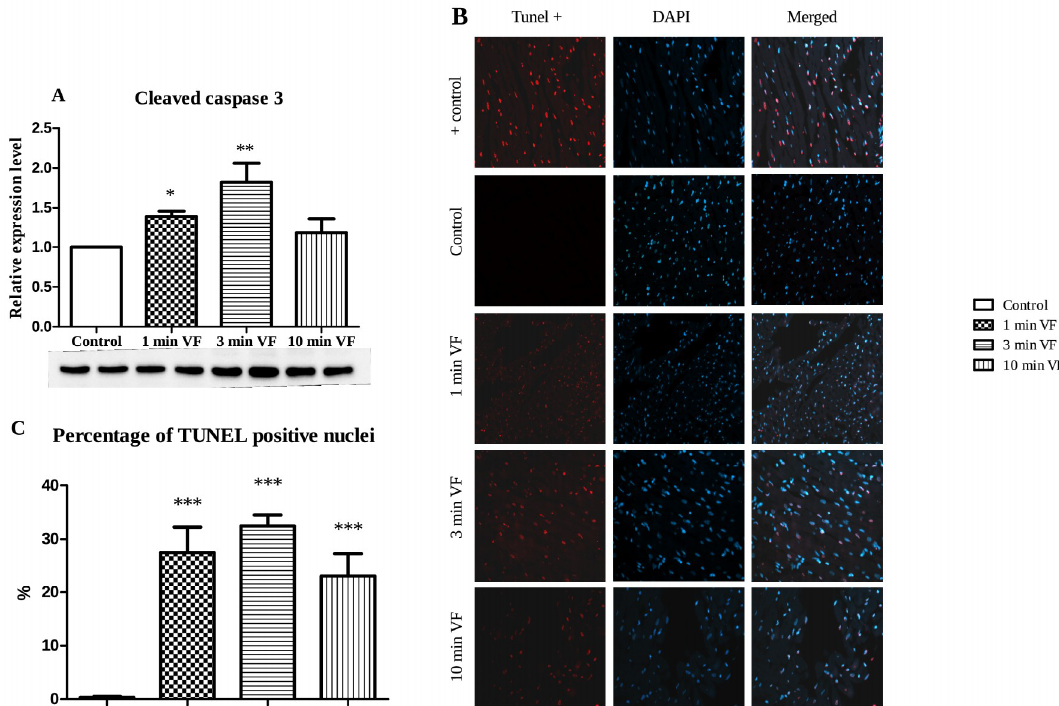
Figure 3. Western blot analysis: Effects of electrically induced fibrillation followed by aerobic perfusion on heart tissue expression of cleaved-caspase-3. Cleaved caspase-3 expression ( A ), representative TUNEL positivity ( B ), and percentage of TUNEL positive nuclei (visualized by a Zeiss AxioScope A1 microscope, EC Plan-Neo fluar 40 × /0.75 M27 objective lens with HBO100 illuminator and Zeiss AxioCam ICm1 camera (Zeiss, Jena, Germany) ( C ) are depicted. n = 8 in each group, mean ± SEM, comparisons were made to the fibrillation-free control group. * p < 0.05, ** p < 0.01, and *** p <